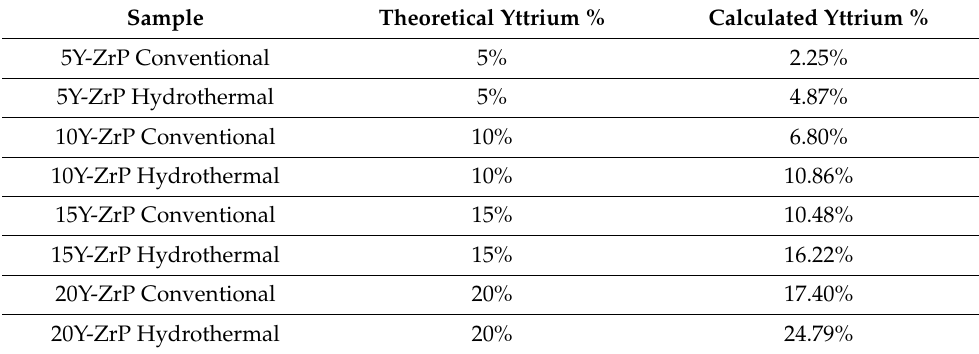
Table 1. Yttrium percentage in Y–ZrP samples as obtained from XRF analysis.